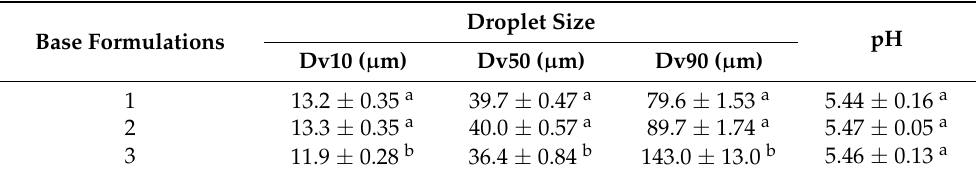
Table 3. Droplet size (Dv10, Dv50, and Dv90) and pH variation of the 3 base formulations (mean ± standard deviation, n ≥ 3). Base Formulations